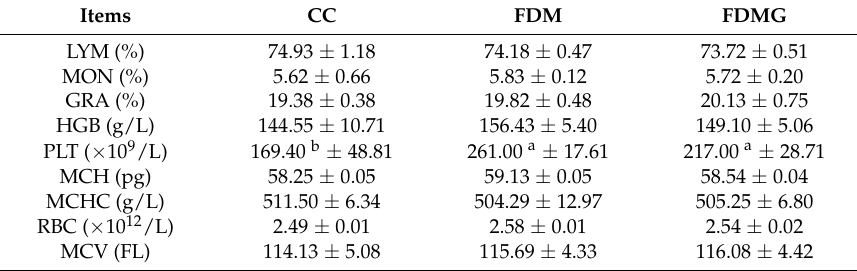
Different superscript letters a and b represents the statistical difference in the same line. LYM = lymphocyte, MON = monocyte, GRA = Granulocytes, HGB = hemoglobin, PLT = platelets, MCH = mean corpuscular hemoglobin, MCHC = mean corpuscular hemoglobin concentration, RBC = red blood cell count, and MCV = mean red cell volume. n = 10 in each group.